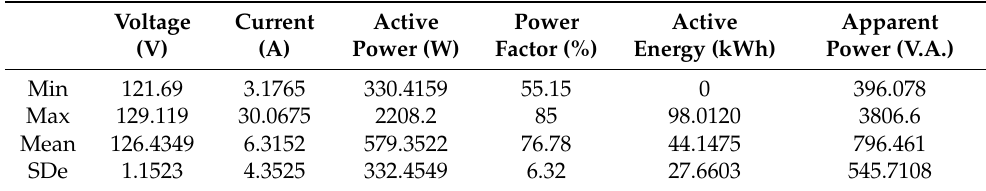
Table 7. Statistical data of the readings made with Sensor 2 of the proposed system during the dates of 23 June and 30 June 2022.